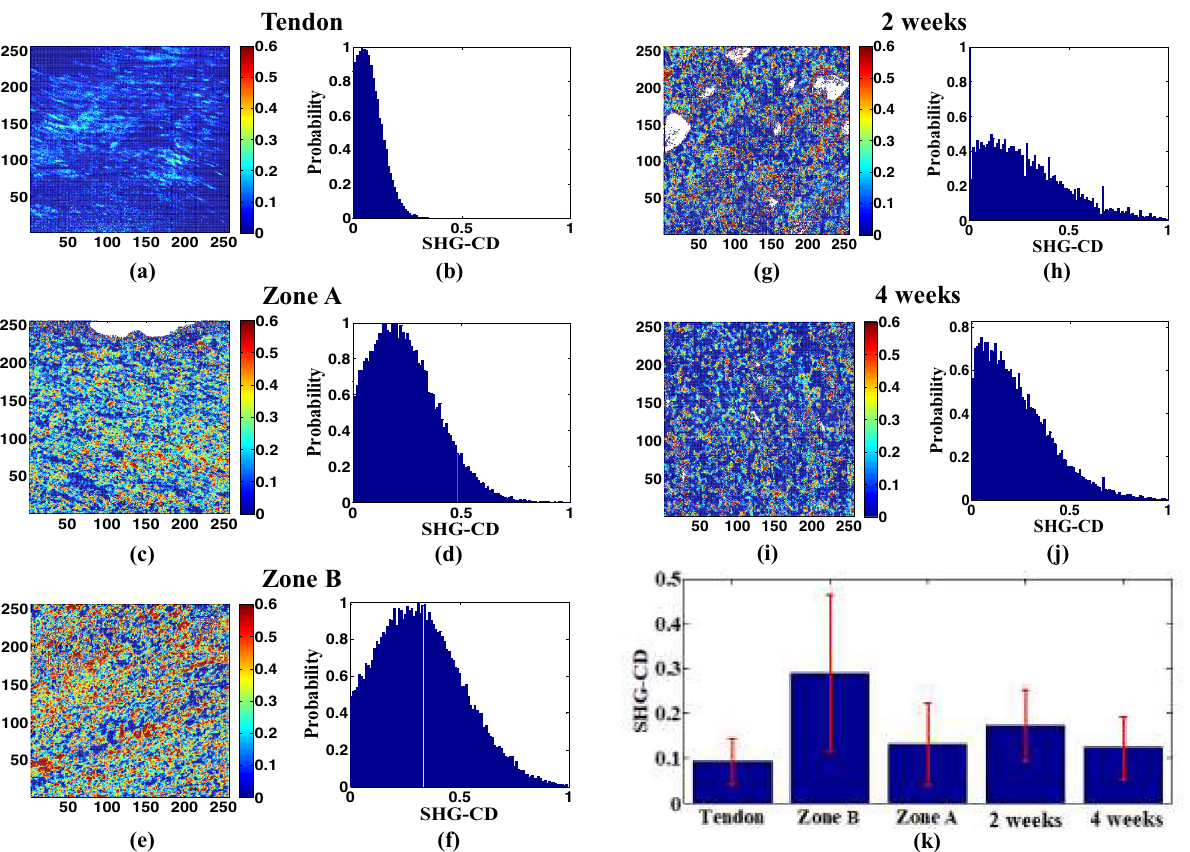
Figure 3. SHG-CD maps and corresponding SHG-CD histograms for ( a , b ) tendon, ( c , d ) cortical bone (Zone A), ( e , f ) articular cartilage (Zone B) of healthy bone control sample, ( g , h ) bone fracture repair at 2 weeks, and ( i , j ) bone fracture repair at 4 weeks. ( k ) Averaged SHG-CD values for tendon, articular cartilage (Zone B), cortical bone (Zone A), fracture repair at 2 weeks, and fracture repair at 4 weeks. Error bars represent standard error of mean. The image size is 50 × 50 μm 2 . The tendon and Zone A (COL I) have lower SHG-CD value as compared to Zone B (COL II), as observed in the colormaps ( a , c , e ). Similar decrease in the SHG-CD value can be observed for the colormap of 4 weeks ( i ) rich in collagen type I as compared to 2 weeks ( g ). The healing tissues are significantly different at p < 0.05. All the image maps, histograms, and bar graphs were generated by using MATLAB R2019a (Version: 9.6.0.1072779, https:// www. mathw orks. com/ produ cts/ new_ produ cts/ relea se201 9a.